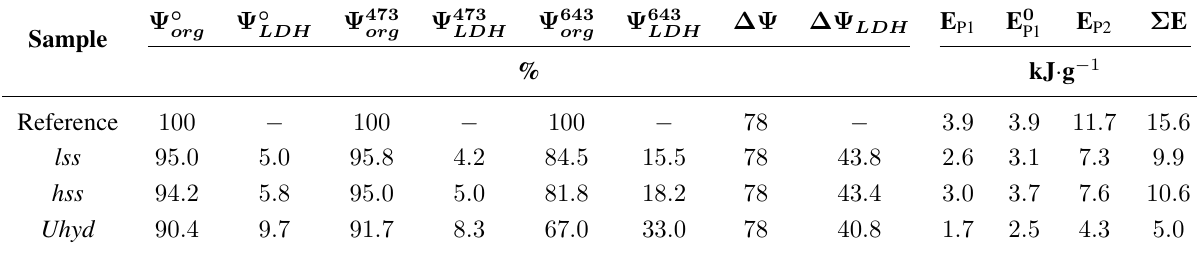
). Relative average total mass loss and Ψ 643 org LDH